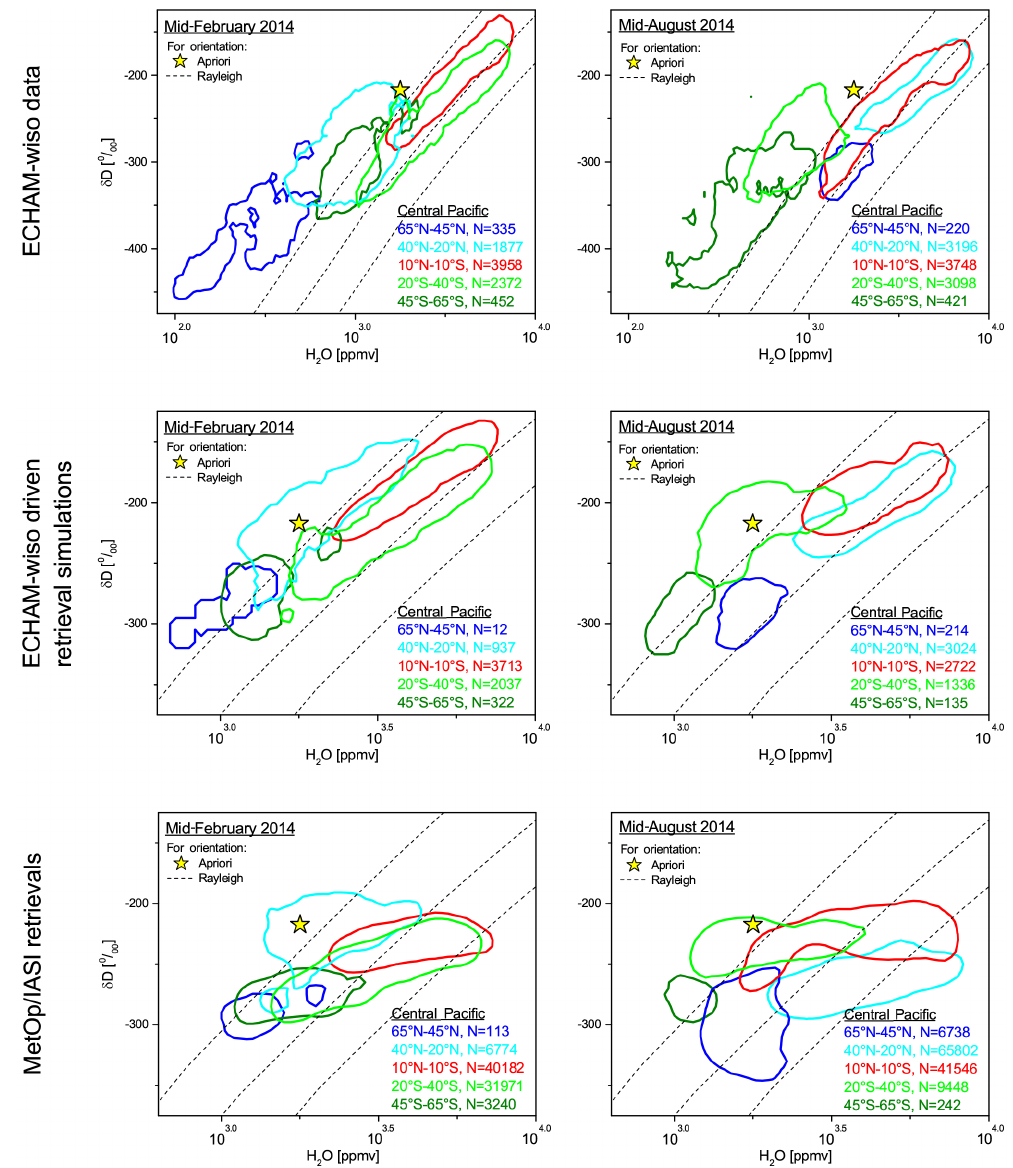
Figure 11. Latitudinal- and seasonal-scale signals in the {H 2 O, δ D} pair distribution in the free troposphere over the central Pacific (140 ◦ E– 140 ◦ W). From the top to the bottom: distributions obtained from ECHAM-wiso simulations, from ECHAM-wiso simulations after passing through the retrieval simulator and from the MetOp/IASI retrievals, respectively. Left panels for mid-February and right panels for mid- August. The different colours represent the different latitudinal belts as given in the legend. The black dashed lines represent Rayleigh curves for three different initialisations: { T = 10 ◦ C; RH = 60%; δ D = − 89‰}, { T = 20 ◦ C; RH = 80%; δ D = − 78‰} and { T = 30 ◦ C; RH = 100%; δ D = − 69‰}. The yellow star marks the a priori value used for the remote sensing retrievals at 5km. Please note the different scale for the plots in the top